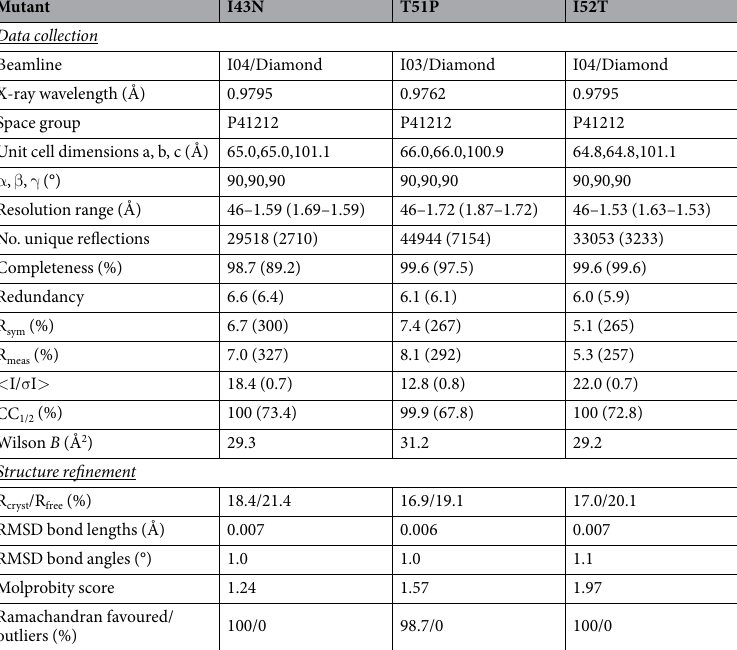
Table 2. Crystallographic data collection and structure